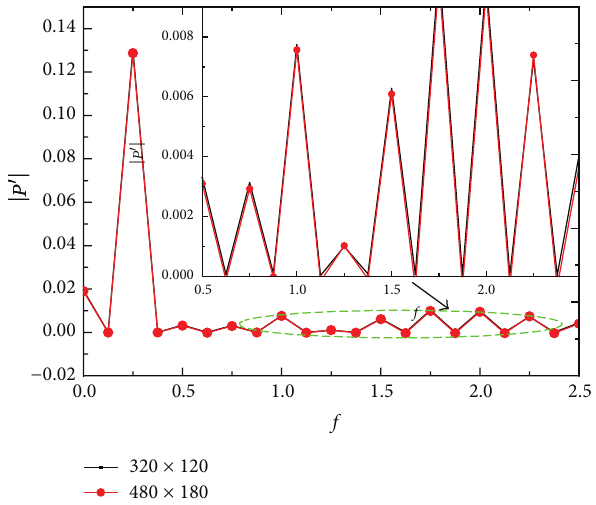
Figure 2: Computational model.